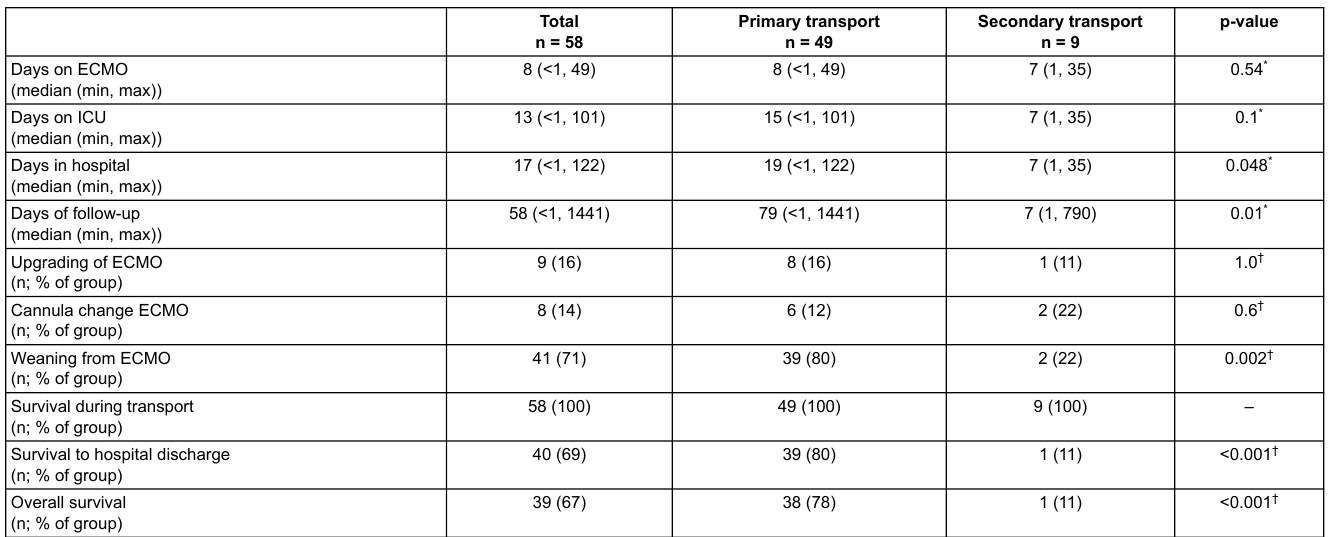
Table 4B: Follow-up data by type of transport.